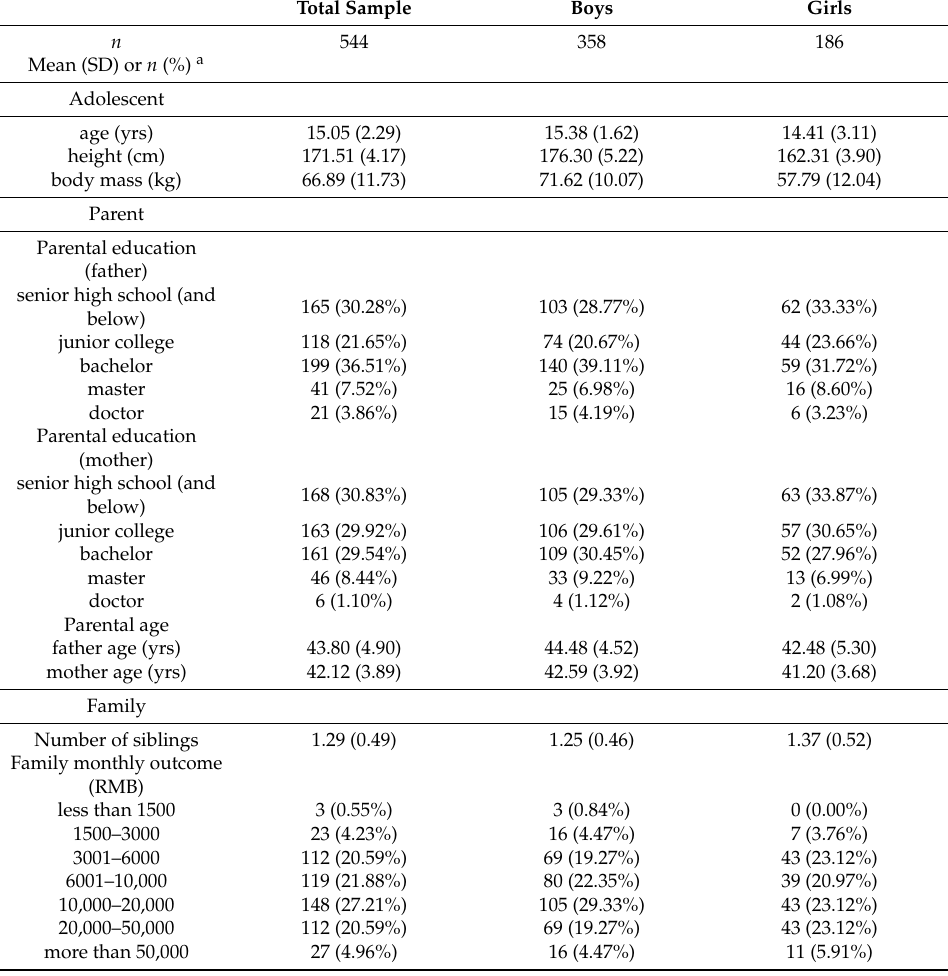
Table 1. Descriptive characteristics of 545